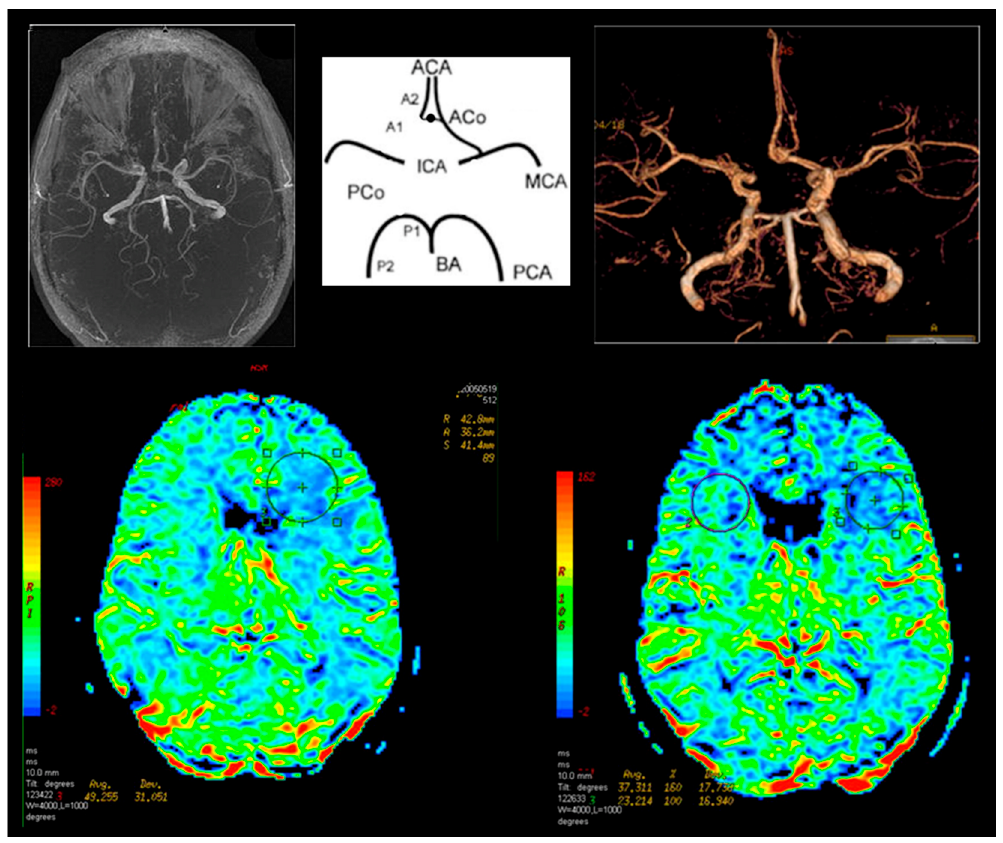
Figure 4. Magnetic resonance brain perfusion with Acetazolamide and magnetic resonance angiography of the intracranial arteries. Right internal carotid artery—70%, left internal carotid artery—90% (operated side). Differences after admission of Acetazolamide marked with circles (right side).